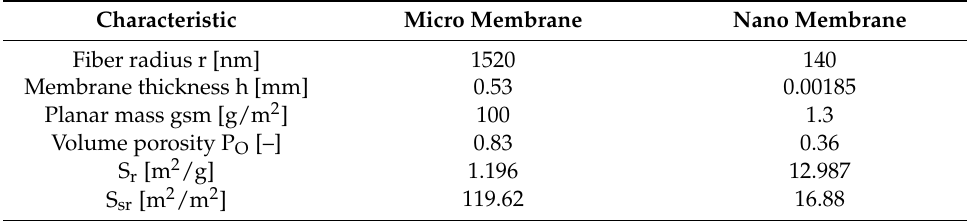
Table 1. Characteristics of typical membranes.